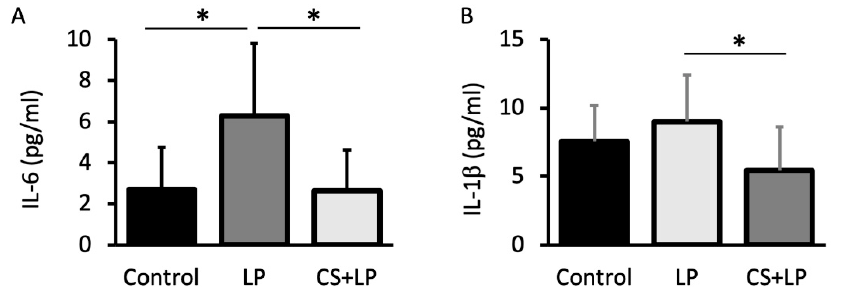
Figure 6. Tear IL-6 and IL-1b concentration comparisons after 7 days of eye drop use. ( A ) Note the significantly higher mean tear IL-6 concentration in Group 2 (LP group) compared with Group 1 (no treatment group) and Group 3 (CS + LP group) ( p = 0.01 and p = 0.009, respectively). ( B ) Note the significantly higher mean tear IL-1b concentration in Group 2 (LP group) compared with Group 3 (CS + LP group) ( p = 0.01). * represents p <